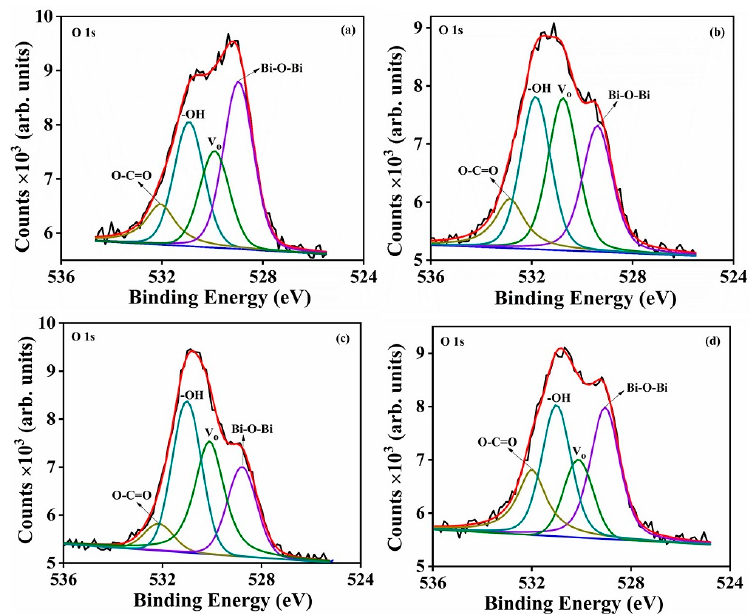
Figure 18. High ‐ resolution XPS spectra of O 1s for Bi 2 O 3 :Ho 3+ thin films deposited at different O 2 Figure 18. High-resolution XPS spectra of O 1s for Bi 2 O 3 :Ho 3 + thin films deposited at di ff erent O 2 partial pressures (T S = 400 °C): ( a ) 5 mT, ( b ) 20 mT ( c ) 100 mT and ( d ) 100 mT. partial pressures (T S = 400 ◦ C): ( a ) 5 mT, ( b ) 20 mT ( c ) 100 mT and ( d ) 100 mT. Table 7. O 1s peak positions and peak areas of the Bi 2 O 3 :Ho 3+ thin films deposited at different O 2 partial pressures (T S = 400 °C).